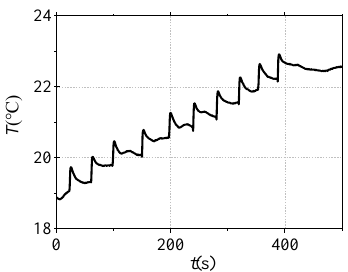
Figure 9. Change of temperature measurement with time.